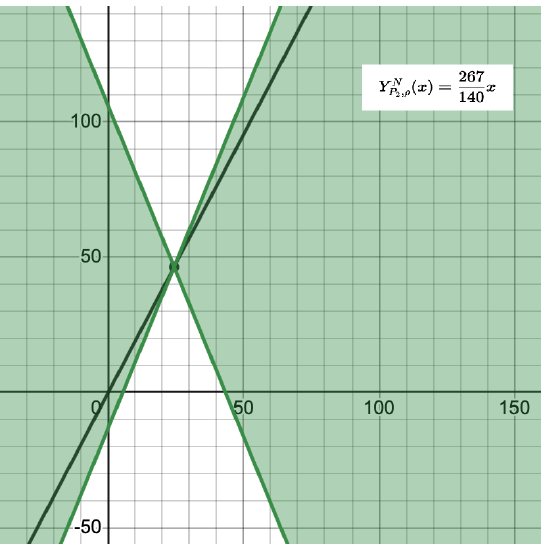
Figure 2. Graph of Lipschitz-continuous of generalized Yosida approximation